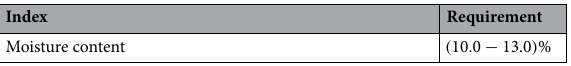
Table 5. Tobacco stem re-baking index and requirement.